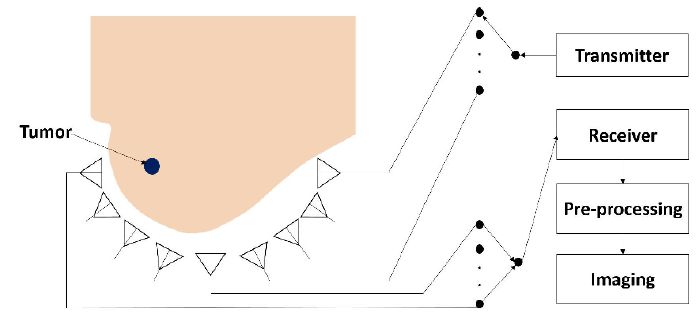
Figure 1. A typical near-field microwave imaging system for breast cancer